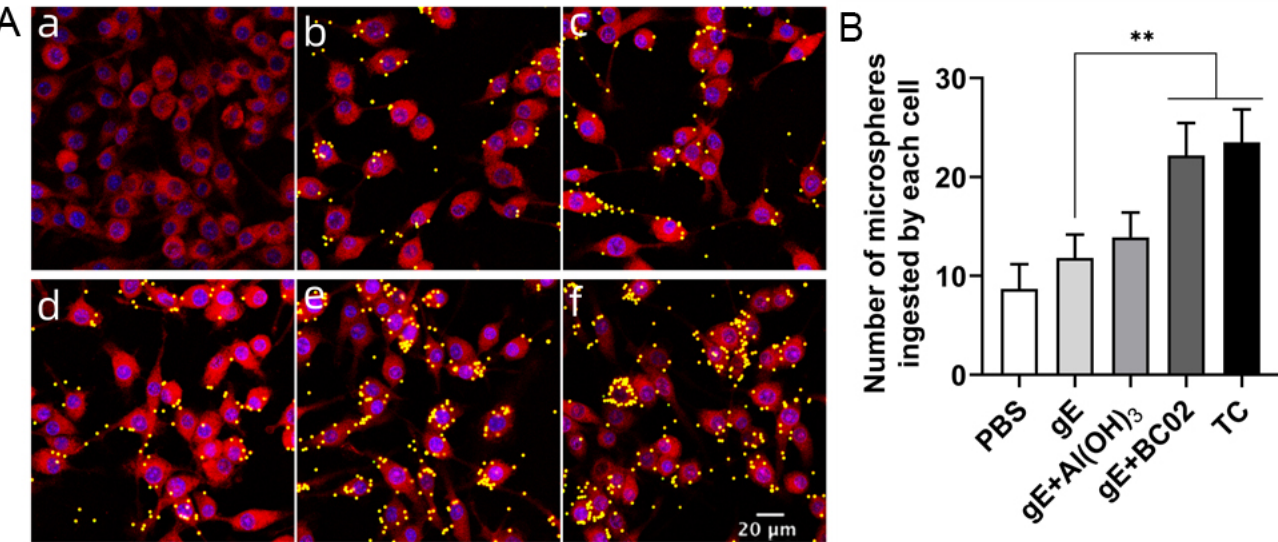
Figure 8. The BC02-adjuvanted gE experimental vaccine up-regulates the phagocytosis of murine macrophages. RAW264.7 cells were stimulated with 1/25 dose of experimental vaccine and incubated with fluorescent microspheres at 37 °C for 1 h. After washing with sterile PBS, macrophages were labeled with CellMask™ Deep Red plasma membrane stain, and confocal microscopy was used to analyze phagocytosis. ( A ): Representative images after laser scanning confocal microscopy acquisition showing differential phagocytosis by RAW264.7 cells. ( a – f ): for Blank control, PBS, 1/25 dose of gE, gE + Al(OH) 3 , gE + BC02 and TC groups, respectively. ( B ): Confocal microscopy assisted count of fluorescent microspheres internalized by individual cells. ** Indicates that there is a significant statistical difference between 1/25 dose of TC and gE + BC02 MD compared with the gE group; p < 0.05.